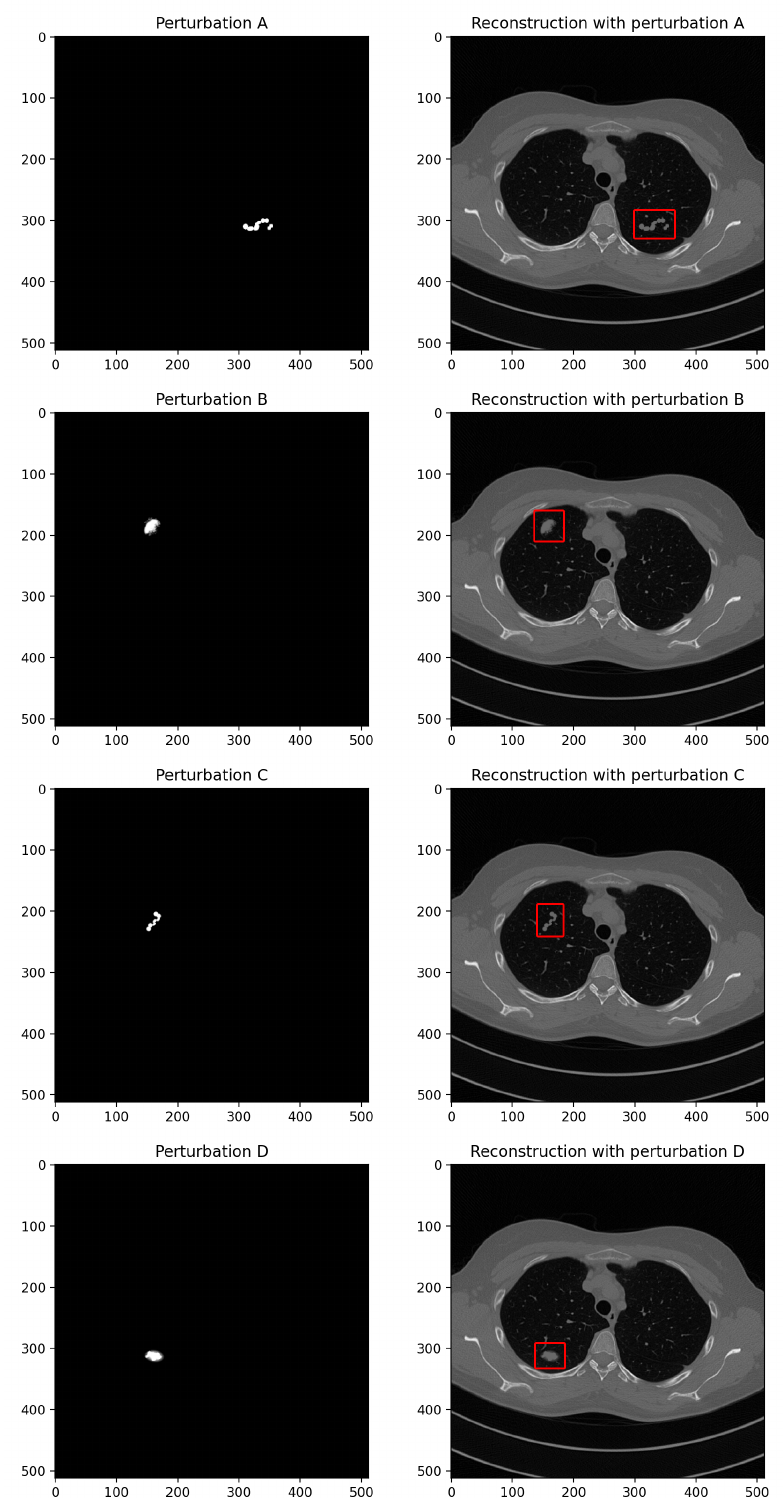
Figure 5. ( A , C ) Airway inflammation and airway impaction. ( B , D ) Asymmetric central bronchiectasis and mucoid impaction, which is typical for allergic bronchopulmonary aspergillosis, and